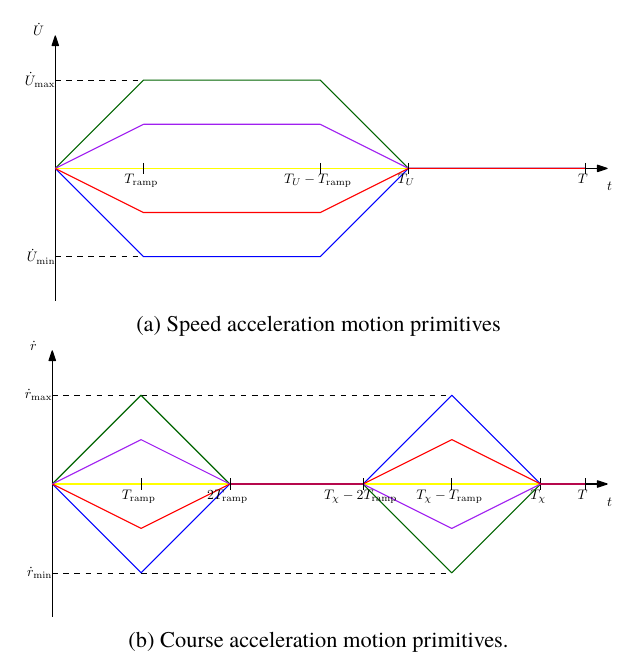
Figure 2: Acceleration motion primitives, where 𝑇 is the step time, 𝑇 denotes the ramp time, while 𝑟𝑎𝑚𝑝 and 𝑇 are the SOG and course maneu- 𝑇 𝑈 𝜒 ver time lengths, respectively. The symbols (cid:164) 𝑈 and (cid:164) 𝑟 denote the acceleration , (cid:164) 𝑈 , (cid:164) 𝑟 max min max min limits of the vessel at the initial vessel state. Cour- tesy of (Eriksen et al.,